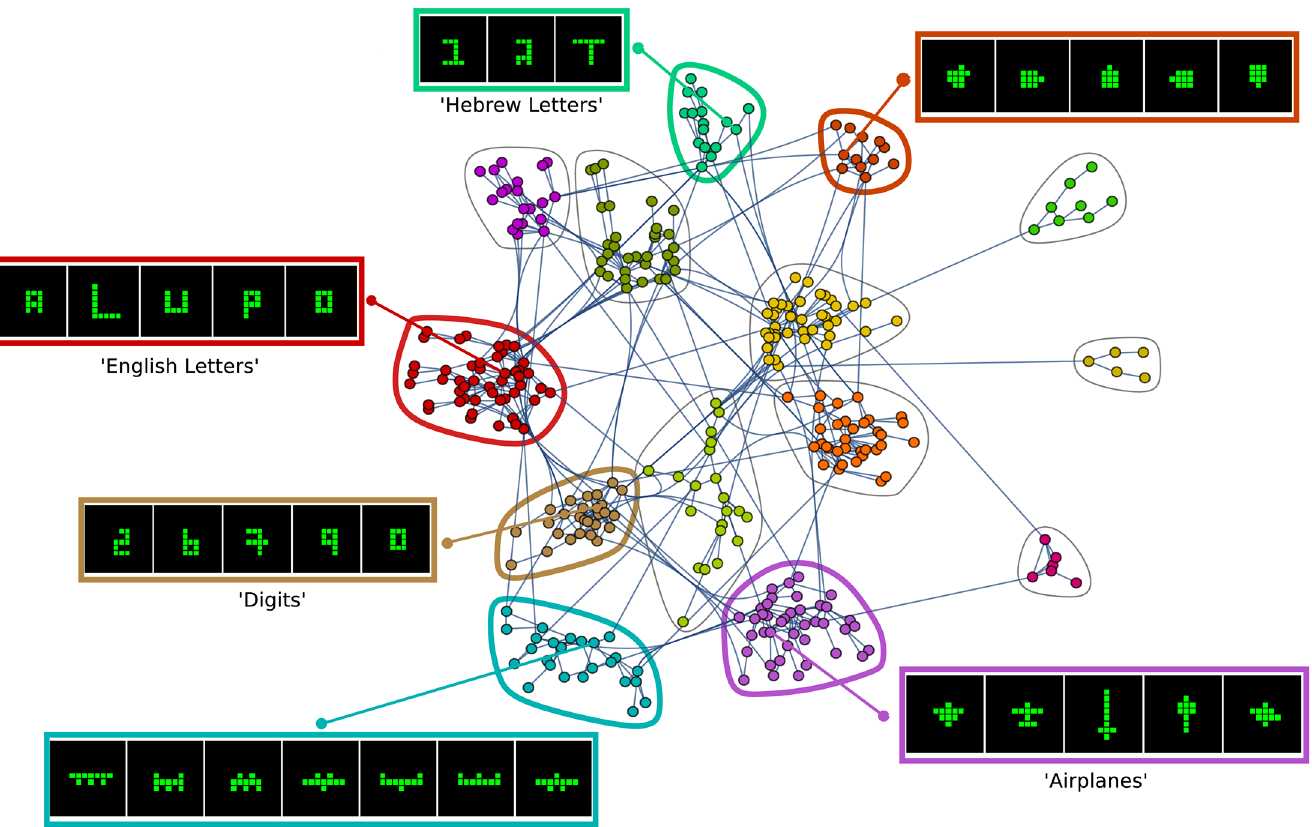
Fig 5. Different players discover similar categories of shapes in their exploitation phases. Network in which nodesare patches (shapesfound in an exploitationphase)from 100 players. Links in the network connect patches that share at least two shapes. Categories are definedas Girvan–Newman modulesin the graph, and are shown in colors, with representative shapes (see Section F in S1 File).